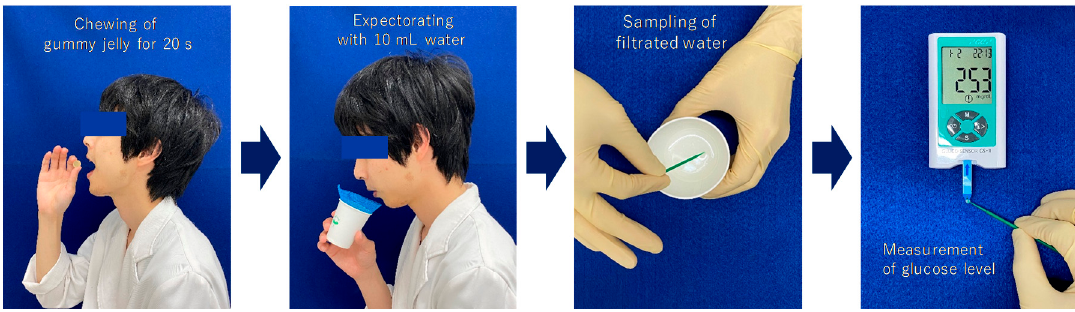
Figure 1. Protocol for the masticatory efficiency test.